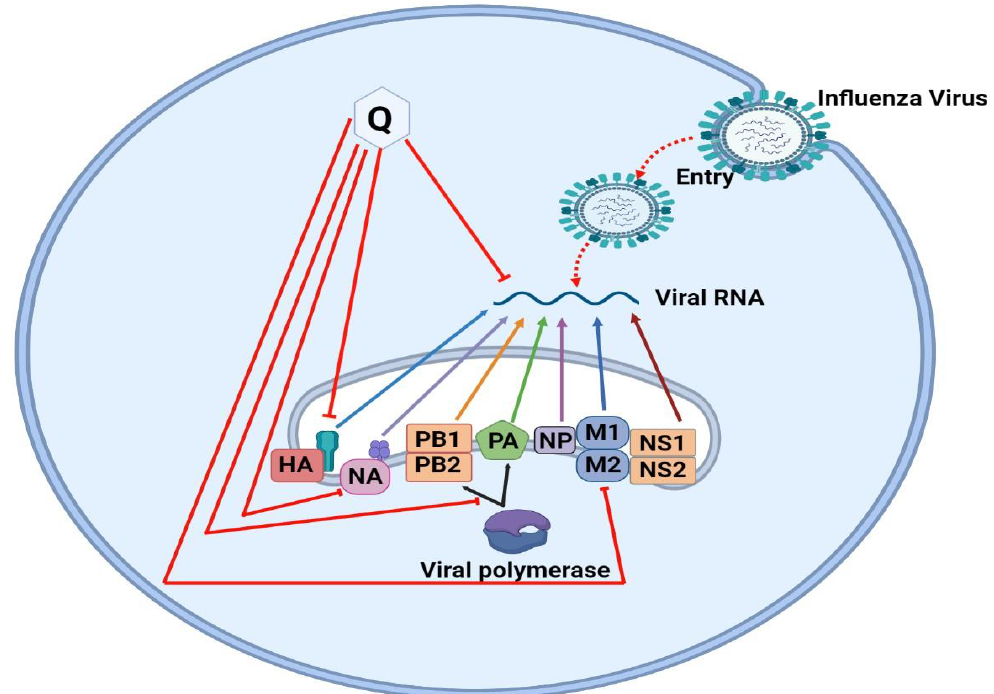
Figure 5. Effects of Quercetin on the Influenza virus. Quercetin augments in destructing the viral polymerase while its major target is viral RNA. Quercetin targets hemagglutinin ( HA), which is a major determinant in subtype specificity. Subsequently the packaging subunit of viral RNA polymerase (PB1, PB2), acidic RNA polymerase (PA), nucleoprotein (NP), matrix protein (M1 and M2) and nonstructural protein (NS1 and NS2) subtypes of viral polymerase finally attenuate the RNA polymerase of Influenza virus through the removal of PB2, PA, NP and M segments .